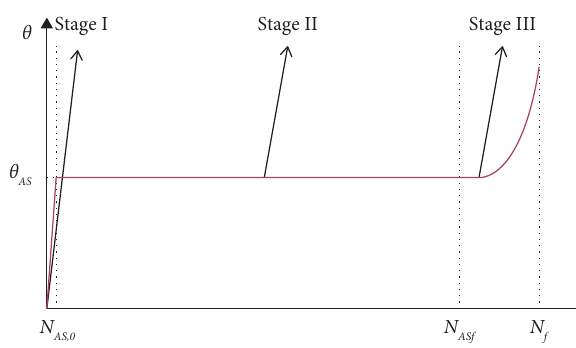
Figure 8: Schematic diagram of temperature evolution versus number of cycles during three stages.